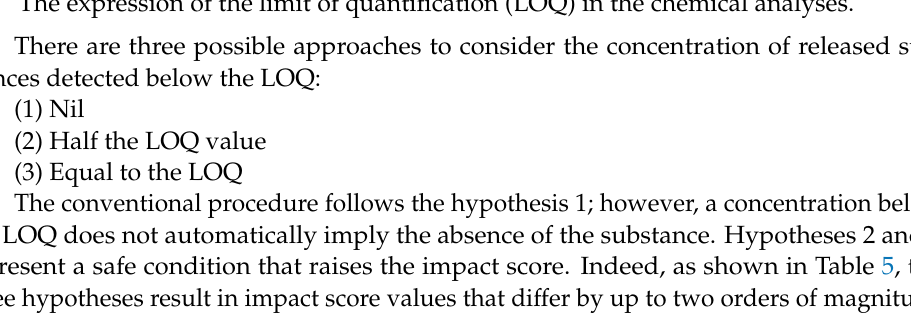
Table 5. Environmental footprint on freshwater ecotoxicity category (expressed as CTU e /m 3 ) and human toxicity/cancer category (expressed as CTU h /m 3 ) calculated according to the standard approach detailed in Recommendation